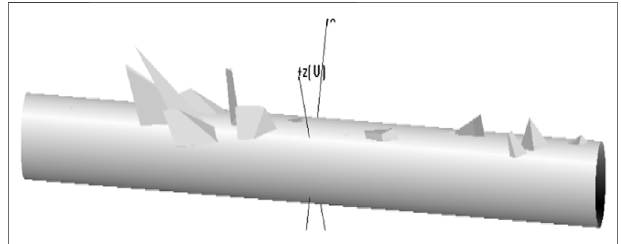
FIGURE 15 | The display of the key